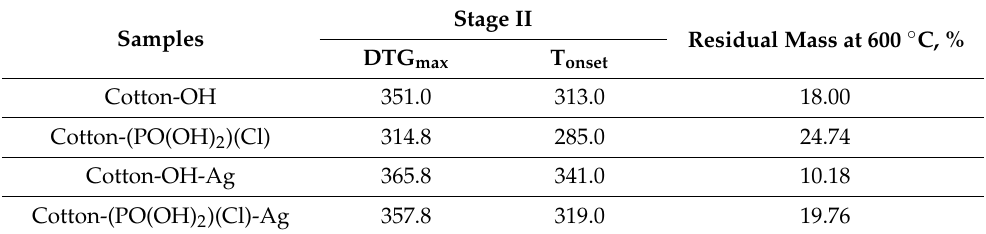
Table 1. The thermal parameters obtained from the TG/DTG curves of the investigated